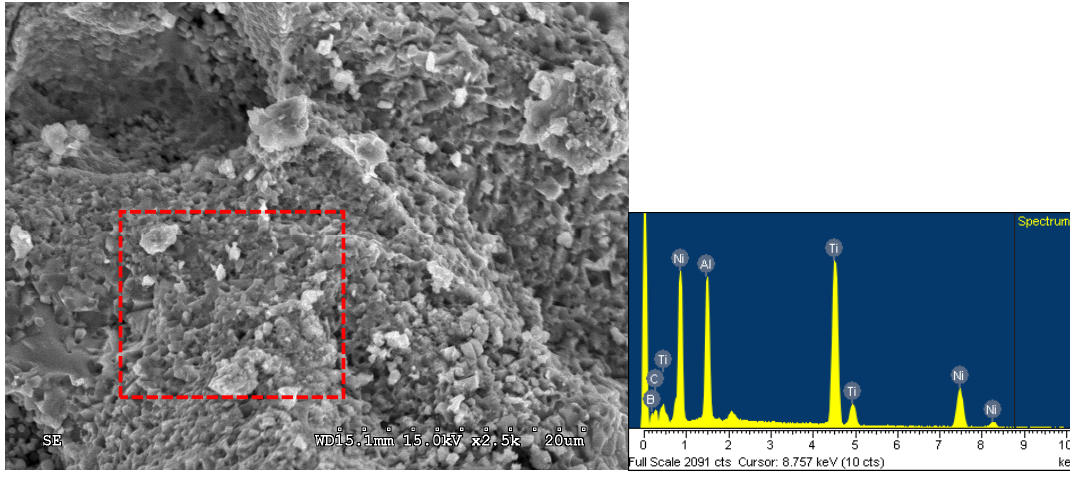
Figure 6. SEM micrograph and EDS spectrum of the 3NiAl + 2TiB 2 + TiC composite synthesized from Reaction (1).